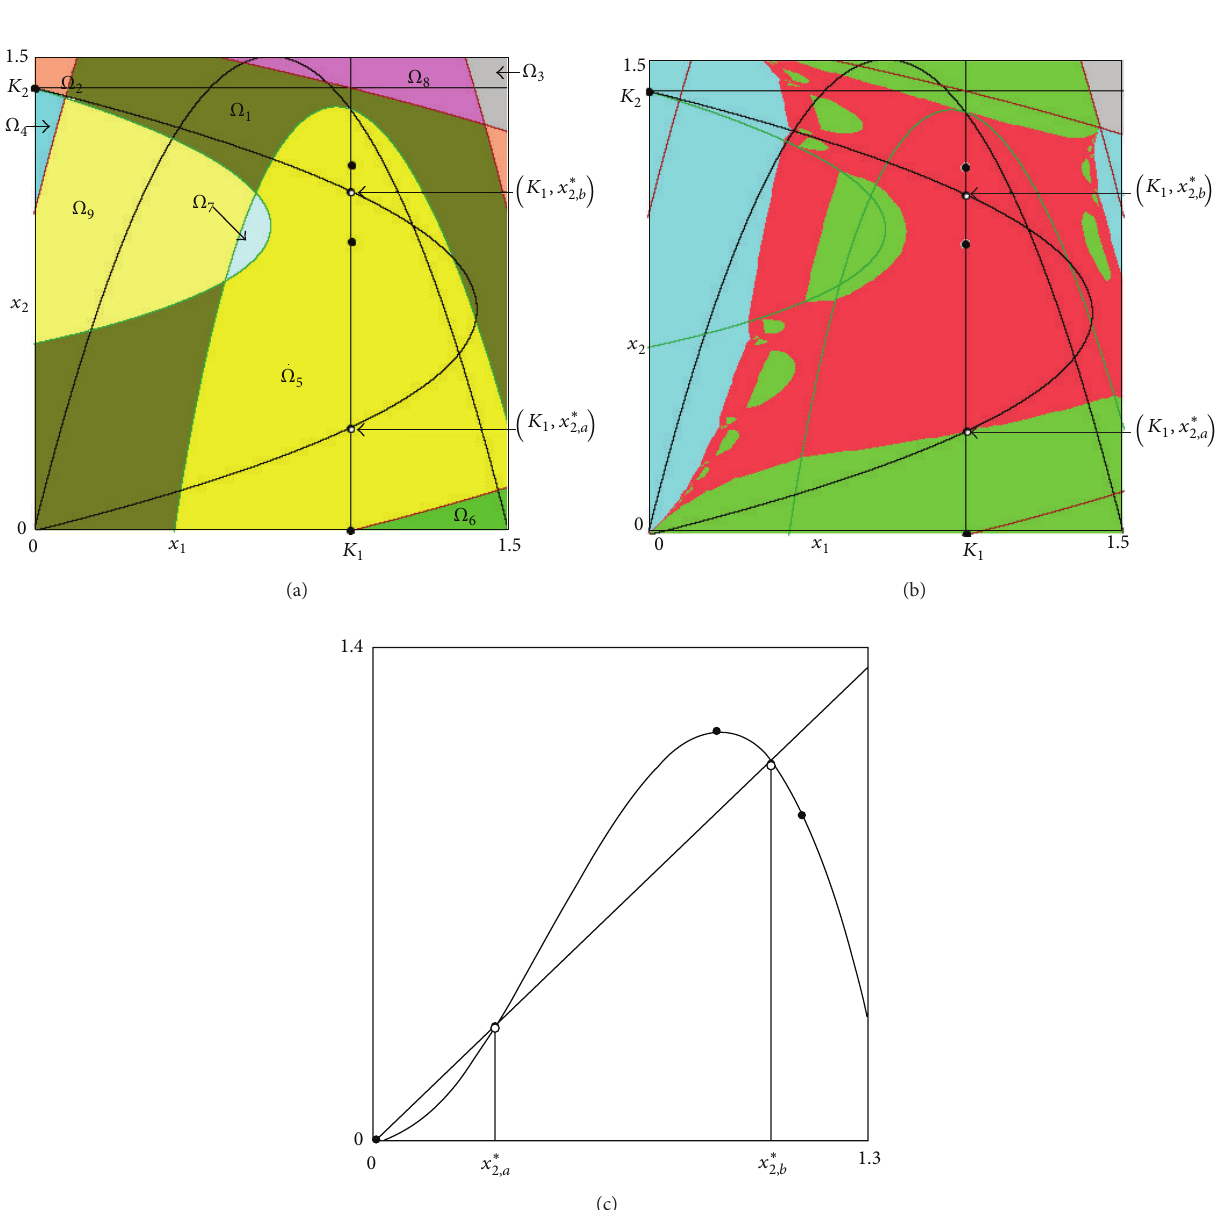
,0) (resp., 1 𝐵𝐶 1,𝐾 and 2,𝐾 are the dark-green